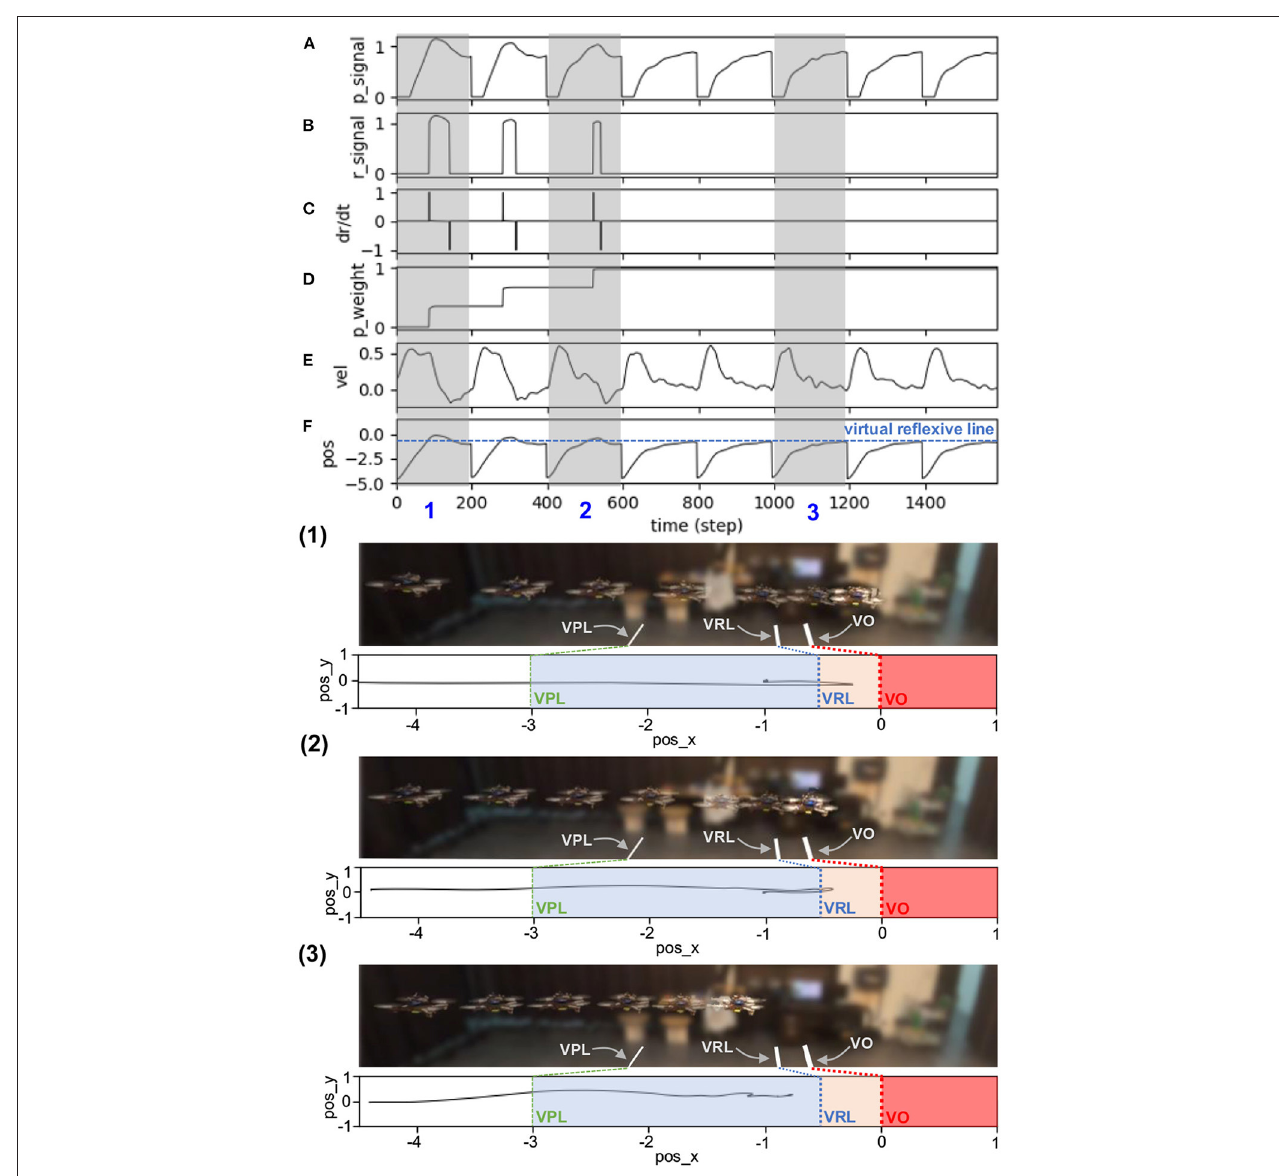
FIGURE 6 | Real-time data of speed adaptation during online learning while flying the UAV at a maximum speed of 0.5 m/s. (A) Predictive signal. (B) Reflexive signal. (C) Derivative of the reflexive signal. (D) Predictive weight. (E) Actual speed (x-axis) of the UAV. (F) Position on the x-axis of the UAV compared to the virtual reflexive line (blue line). The gray areas represent three periods and show the UAV’s position with respect to the virtual predictive line (VPL), virtual reflexive line (VRL), and virtual obstacle (VO). These three periods are shown in the three snapshots together with the corresponding estimated trajectories (1, 2, 3) namely the beginning of learning (1), during learning (2), and after learning (3). A video of this experiment can be viewed on